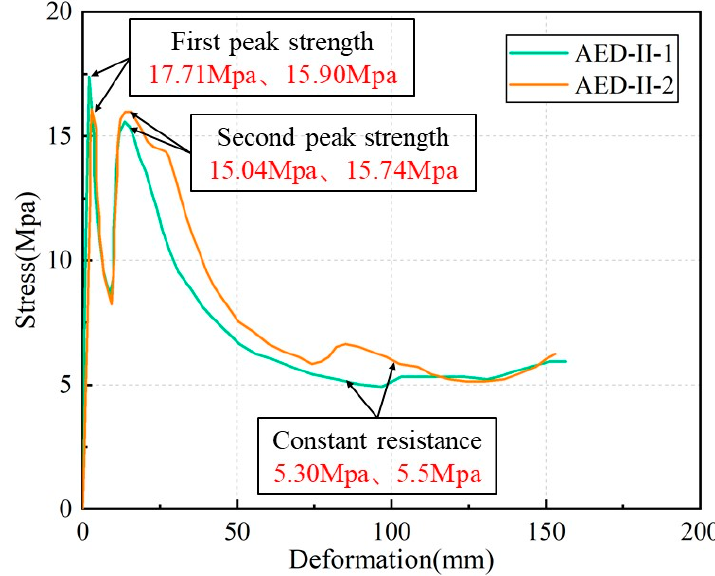
Figure 11. The stress–deformation curve of the AED-IIs.